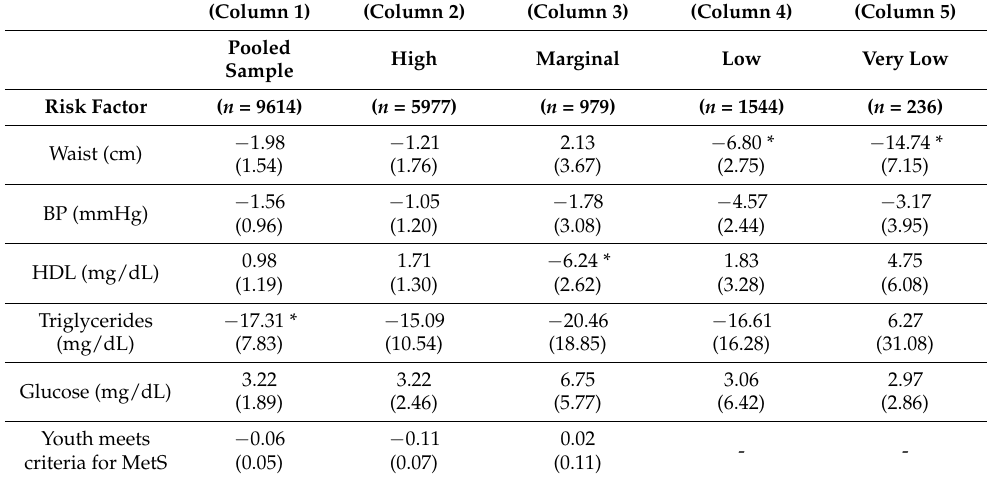
Table A1. Estimated effect of SNAP eligibility on cardiometabolic risk factors in children and adolescents compared to those just over the eligibility threshold: differences across food security (additional